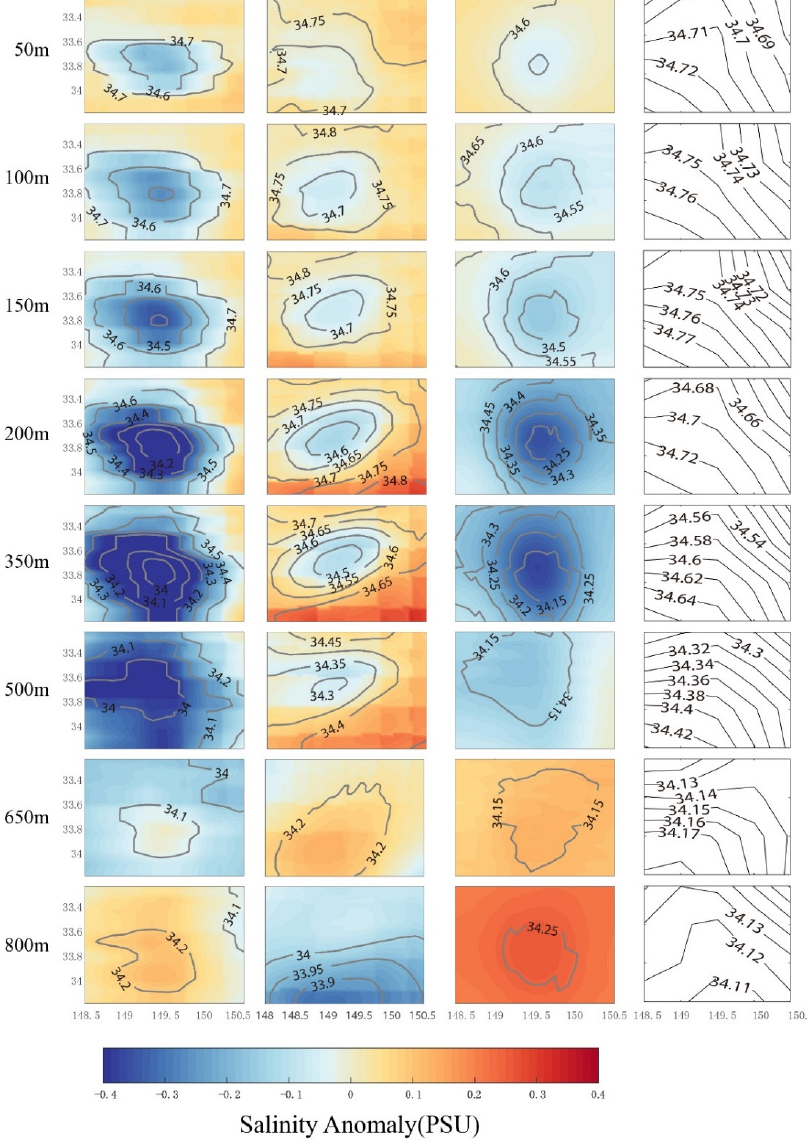
Figure 8. Horizontal salinity distributions along the eight sections in situ. The horizontal axis is longitude and vertical axis is latitude. Same as Figure 7.